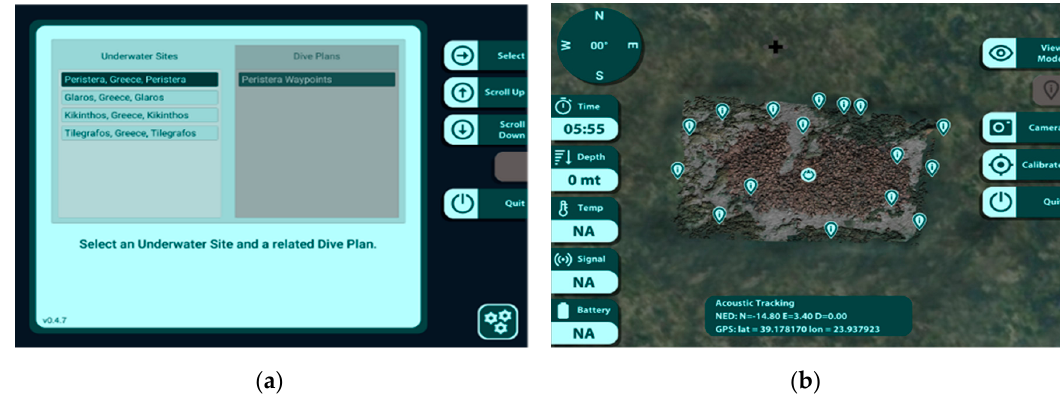
Figure 14. ( a ) The main menu of the app where divers can select the underwater site and the specific thematic route; ( b ) the main screen of the app showing the 3D map of the underwater archaeological site of “Peristera” shipwreck.